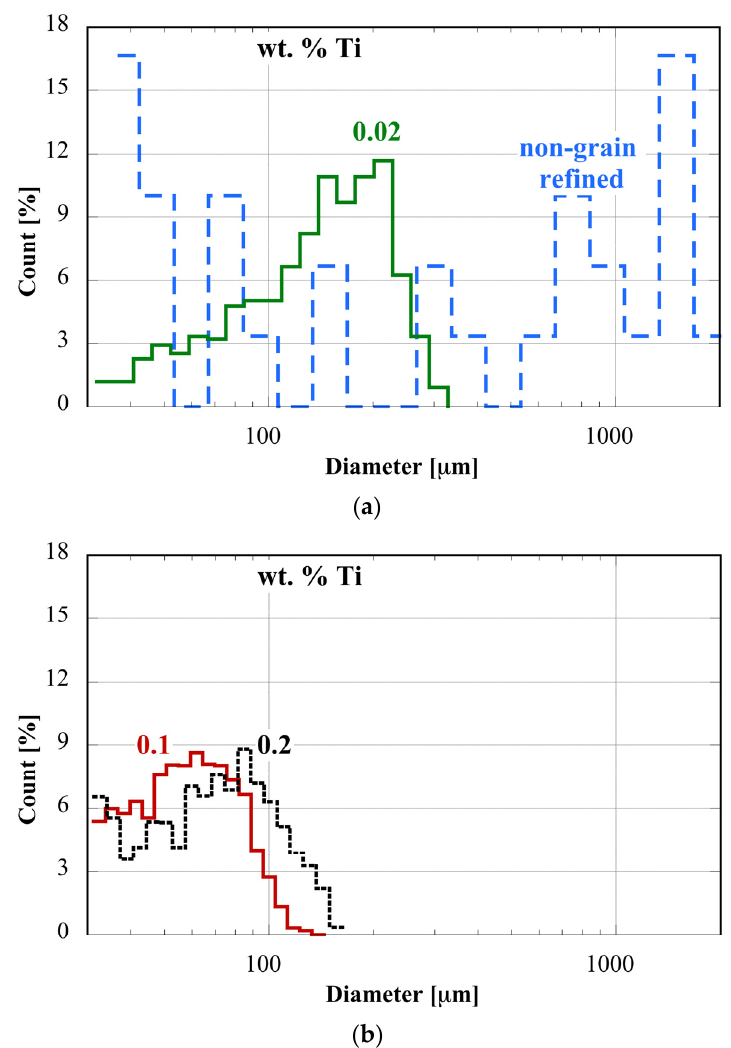
Figure 4. Grain size [ µ m] distribution for the DA2 alloy: ( a ) non-grain refined and grain refined with 0.02 wt.% Ti and ( b ) grain refined with 0.1 and 0.2 wt.% Ti (solid and dotted lines, respectively). Table 2. Median grain size [ µ m] and parameters for intermetallic particle characterization for the DA2 alloy.